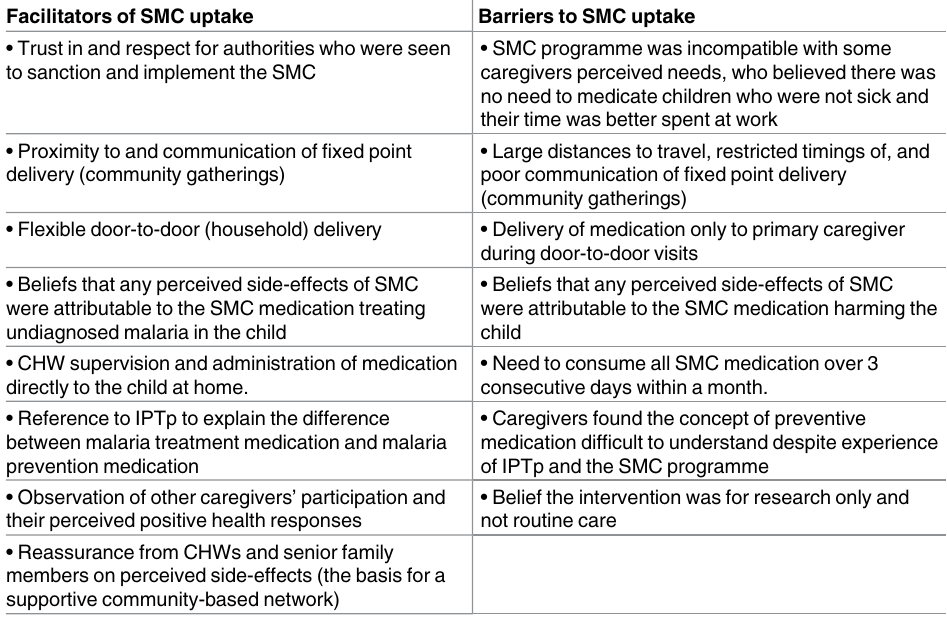
Table 3. Summary of faciltators and barriersto SMC uptake amongst caregiver respondents, col- lected during a qualitative study in Ghana in January